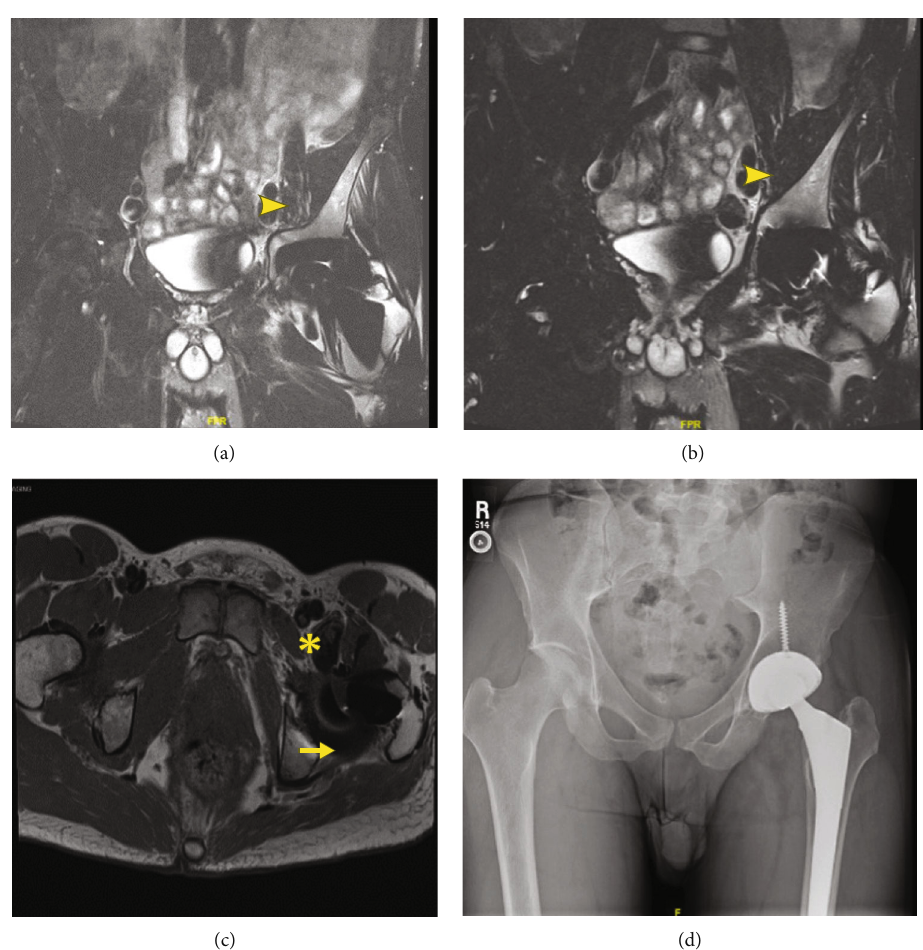
Figure 5: Representative MRI slices and postoperative radiographs of a 29-year-old male with D-TGCT in the left hip. Coronal MRI with metal subtraction (a, b) demonstrates near resolution of the intrapelvic tumor burden (arrowhead). Axial imaging (c) demonstrates absence of posterior tumor burden after surgical resection (arrow) but persistence of the small anterior tumor along the psoas muscle ( ∗ ). A well- fi xed cementless total hip arthroplasty is demonstrated